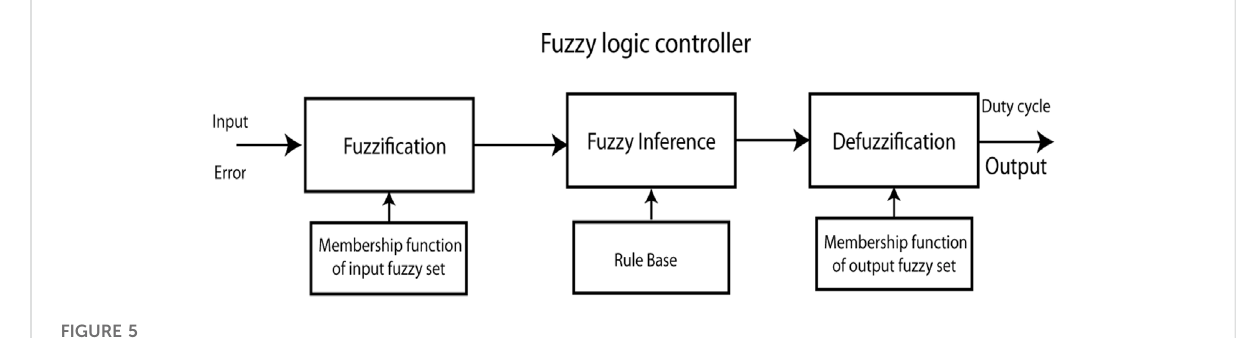
FIGURE 5 Fuzzy logic control